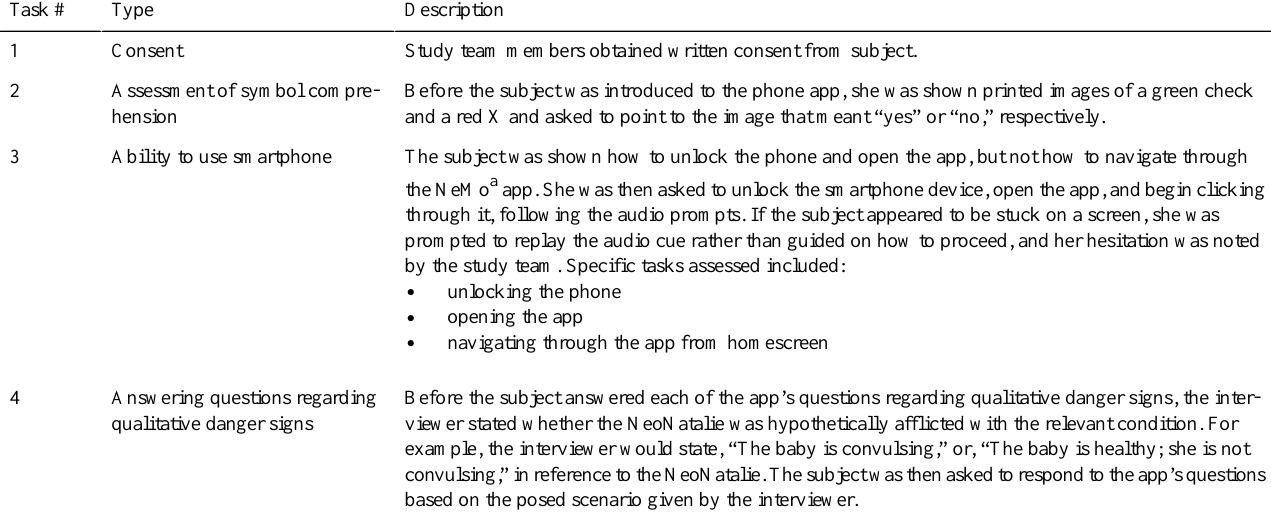
Table 1. Outline of study tasks and questions asked regarding the subjects' experience using the NeMo system. DescriptionTypeTask # Study team members obtained written consent from